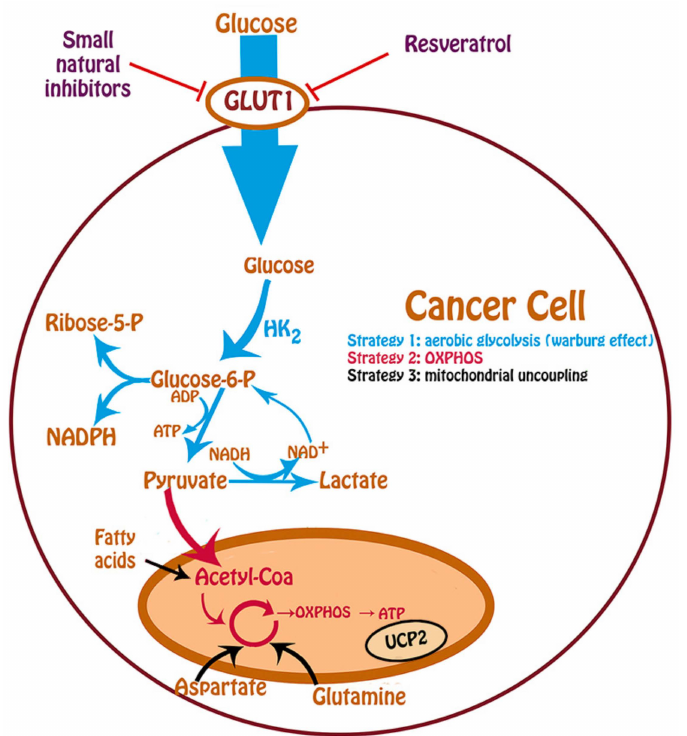
Figure 1. Glucose metabolism in cancer cells. In strategy 1, glucose is uptake is by GLUT1, which is a glucose transporter overexpressed in cancer cells, and follows the glycolytic pathway to pyruvate. The first step is the phosphorylation by hexokinase (HK) and the main isoform upregulated in cancer is HK 2 . Under anaerobiosis, pyruvate is converted to lactate, with the regeneration of NAD + that feeds glycolysis. This way is a source of energy for cancer cells and supplies intermediates like ribose-5-phosphate and NADPH that are required for cell proliferation. In strategy 2, pyruvate obtained by glycolysis is transformed in Acetyl-Coenzyme-A (Acetyl-CoA) that enters in the mitochondrial Krebs cycle and follows oxidative phosphorylation (OXPHOS), the main source of ATP in a normal cell. Finally, in strategy 3, the cancer cell may turn in mitochondrial uncoupling, because it could use substrates that are di ff erent of glucose as a carbon source like fatty acids, aspartate, and glutamine that feeds the Krebs cycle (anaplerotic reactions). There is a mitochondrial carrier named uncoupling protein 2 (UCP2), that has been connected with proliferation and anaplerotic mitochondrial metabolism in cancer cells. The proliferating cells can choose more than one strategy at a